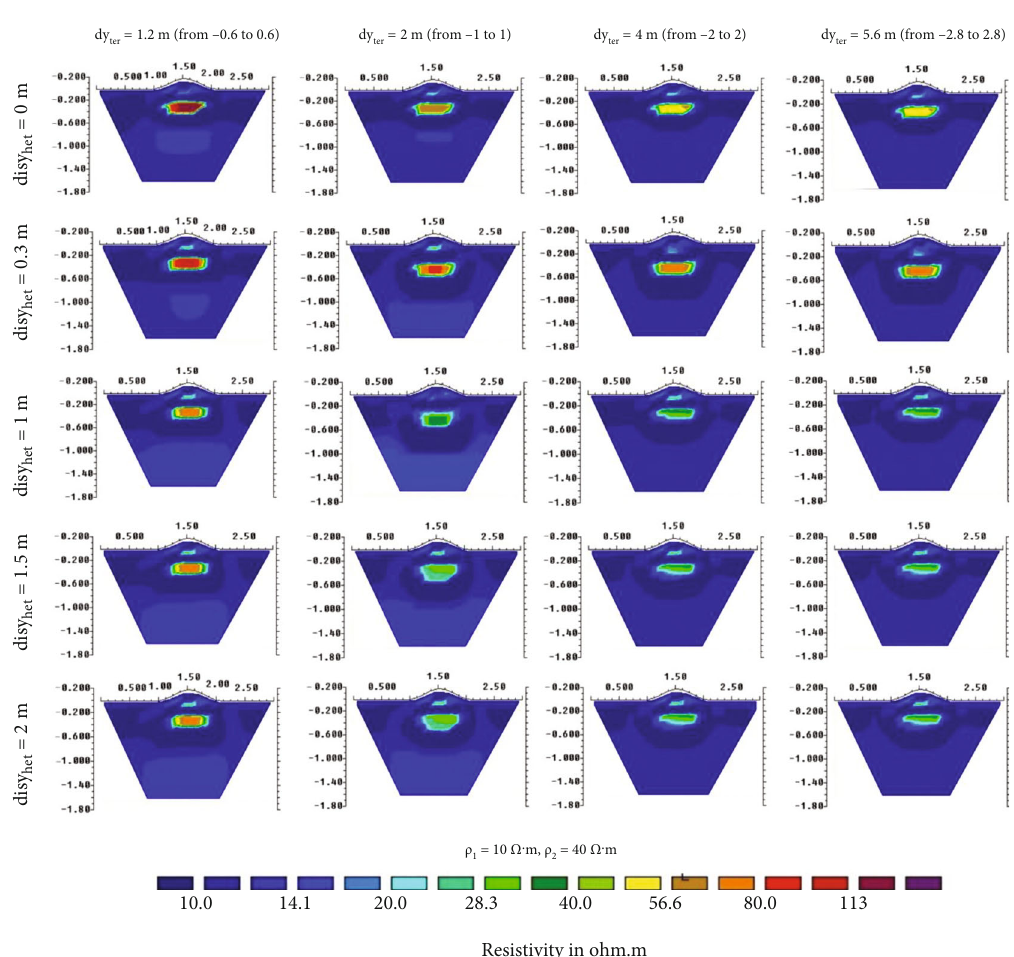
Figure 11: The in fl uence of the inhomogeneity distance in the Y-direction on the results of 2D inversion for a 3D medium with ground surface topography ( ρ 1 < ρ 2